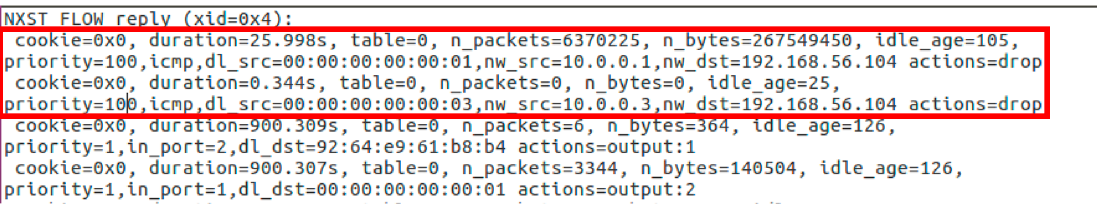
Figure 11. Snort Extra Configuration.